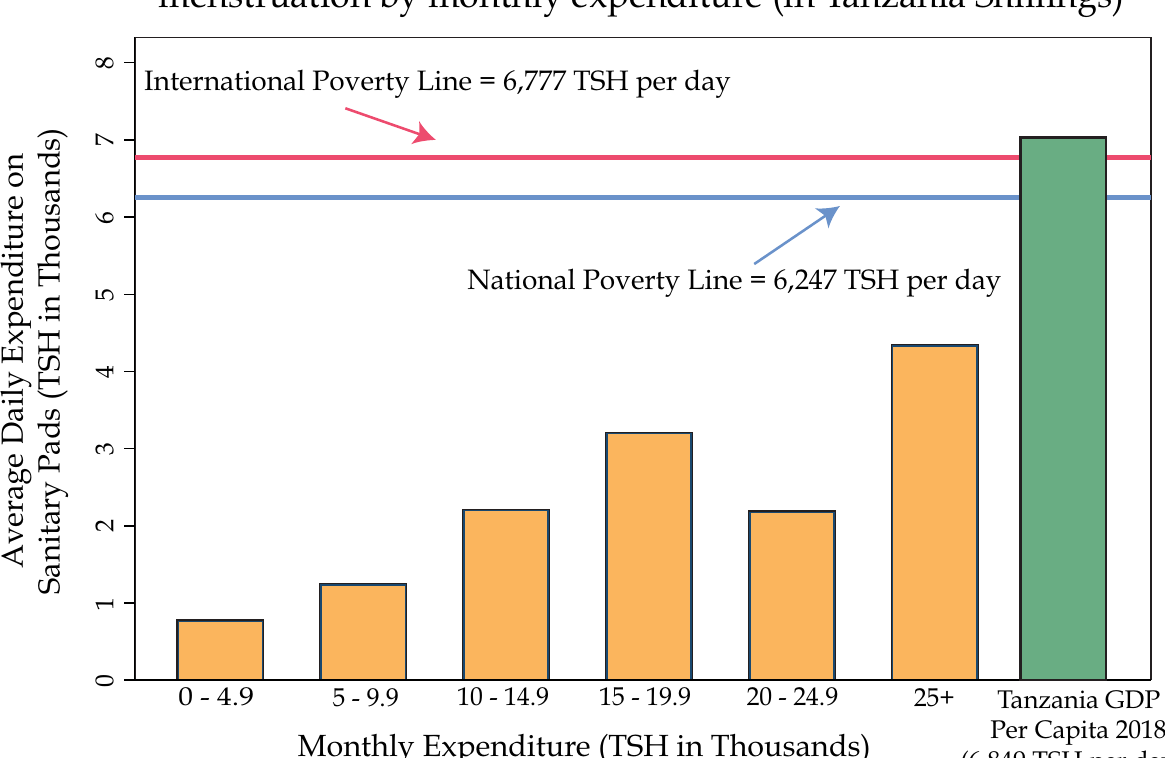
Fig 3. Monthly expenditure and spending on sanitary pads. This figure presents girls’ average daily expenditure on sanitary pads during menstruation (self-reported monthly expenditure on sanitary pads expressed in 1000 TSH, divided by the average length of menstrual period) by their monthly self-reported expenditure (ranked and expressed in 1000s TSH). In addition, the green bar shows the approximate daily value of Tanzania’s 2018 GDP per capita [60] (approximately equivalent to 2.9 USD per capita), the blue line presents Tanzania’s national poverty line [61], the red line indicates the international poverty line